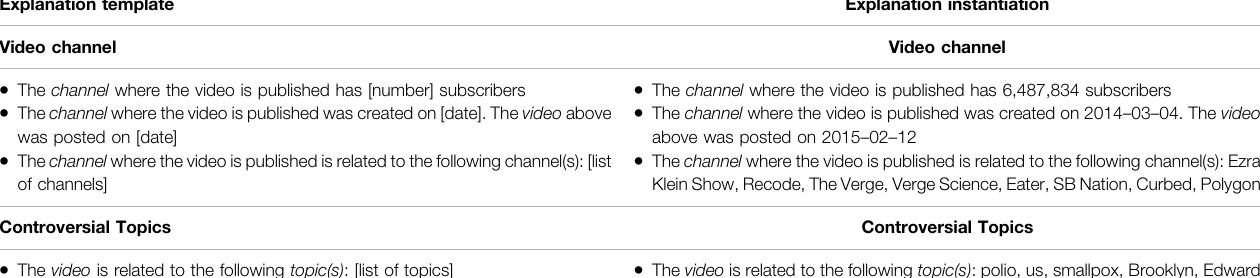
TABLE 2 | Template for generating the re fl ection-driven explanations and the instantiation of the explanations for Supplementary Video V1 in our experiments. Explanation